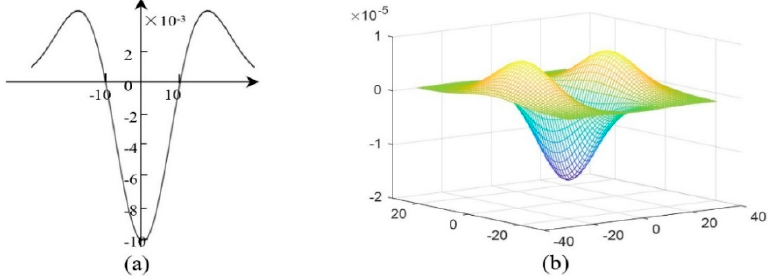
Figure 3. Illustration of the second derivative of Gaussian kernel. ( a ) Second-order derivative of a 1D Gaussian kernel. ( b ) Second-order derivative of a 2D Gaussian kernel. Figure 4b,d show the results of SBP images filtered using multi-scale enhancement filtering method. The reflections from sediment interfaces are enhanced and the other discrete ones are filtered. However, it is noticeable that not only the interface structures are enhanced, but so are some vertical structures, marked with rectangles in Figure 4.